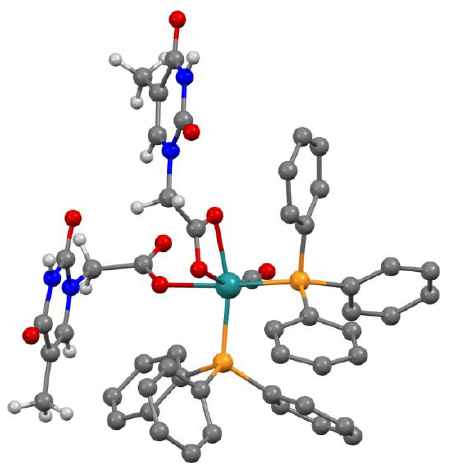
Figure 1. X-ray structure of κ 1 (O)-THAc, κ 2 (O,O)-THAc [Ru(CO)(PPh 3 ) 2 ] cis- 2 . Hydrogen atoms have been omitted for clarity.